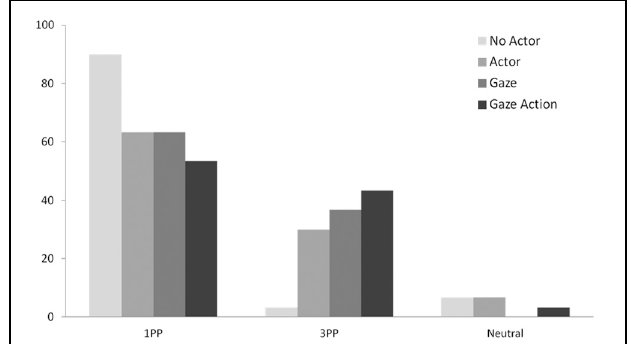
FIGURE 2 | Percentages of 1PP, 3PP, and neutral responses in Experiment 1.